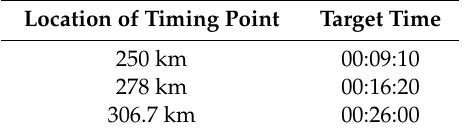
Table 5. Location and target of timing points in the case of two intermediate timing points.